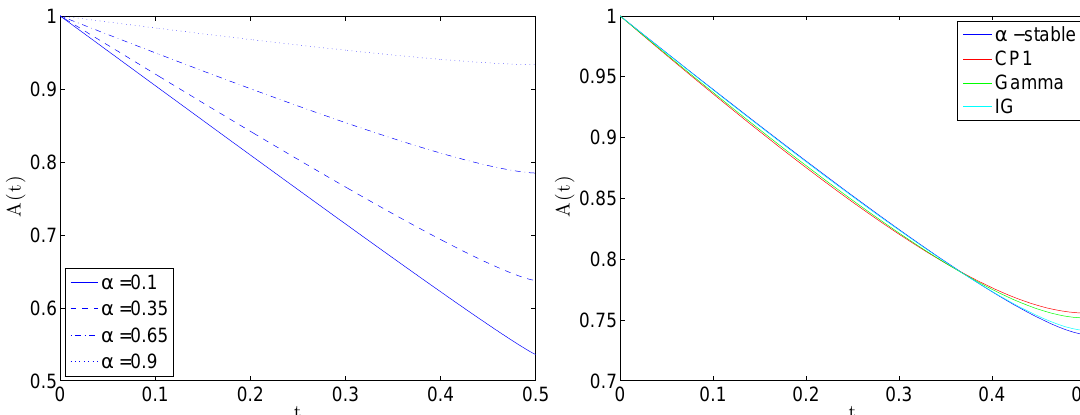
Figure 1: Left: Bivariate Pickands dependence functions for Example 1 ( Ψ H ( x ) = x α ) and different values of α . Right: The bivari- ate Pickands dependence functions for different Ψ H corresponding to the α -stable case, CP1, the Gamma case, and the IG case as defined in Table 1. The parameters in the example to the right are chosen such that all models exhibit a Spearman’s ρ of 0.5